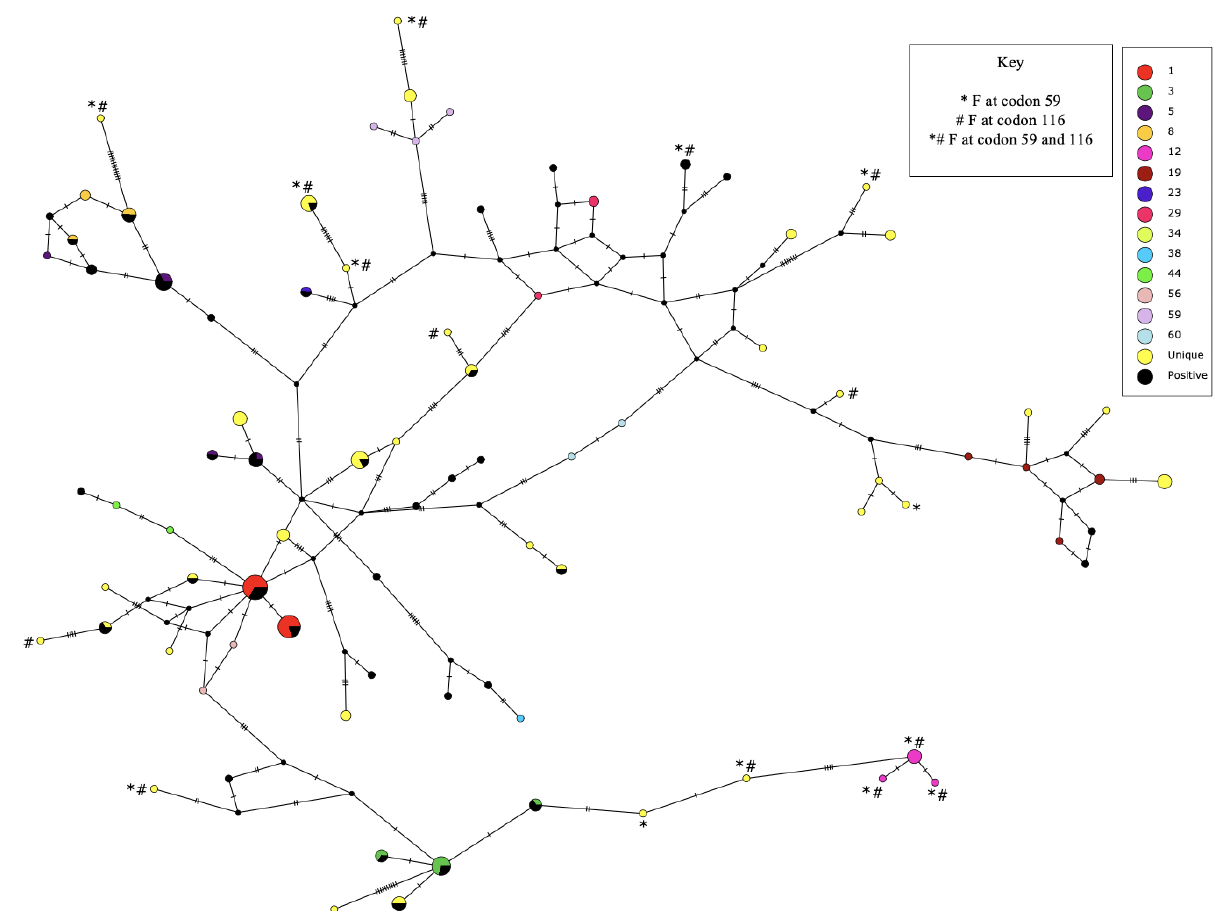
Figure 2. Median-joining network constructed for the 85 TLR3 haplotypes carried by the 84 Illinois deer sequenced (2 n = 168 chromosomes). Each distinct circle represents one unique haplotype, and the sizes of the circles are proportional to the number of chromosomes carrying the haplotype. Color shading is used to distinguish between protein variants encoded by the haplotypes; yellow coloring is used for all haplotypes that encoded a unique protein variant. Black coloring indicates the proportion of each haplotype present in deer testing positive for EHD. Hatch marks indicate the number of mutations between haplotypes. Symbols are placed next to haplotypes with SNPs that were associated with significantly reduced EHD infection: * for haplotypes encoding phenylalanine at codon 59 and # for haplotypes encoding phenylalanine at codon 116; some haplotypes carried both SNPs.